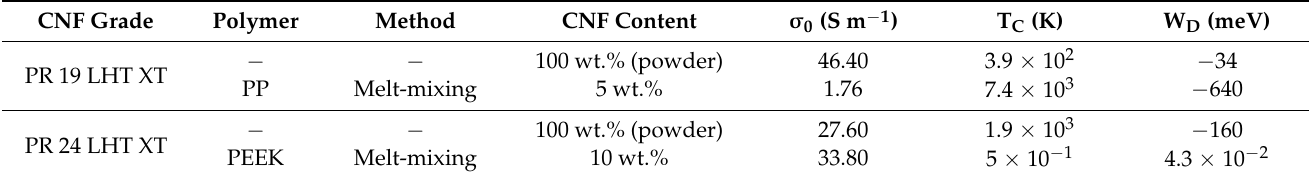
Table 4. Parameters σ 0 , T C , and W D extracted from VRH model of CNF powder and PP/5 wt.% CNF composites analysed in previous study [32], and CNF powder and PEEK/10 wt.% CNF composites analysed in this